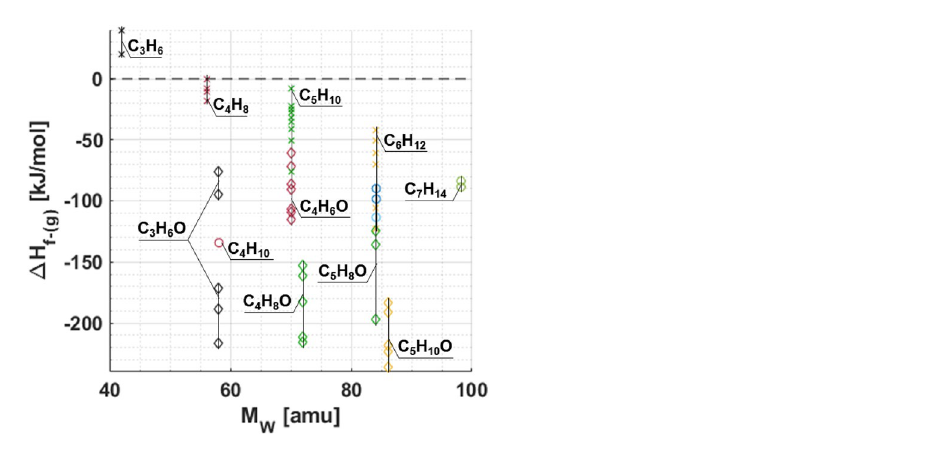
Figure 8. Standard enthalpy of formation versus molecular mass of various species and those of the intermediate species identified from DIB oxidation reactions. Colors shown are to differentiate compositions at near mass